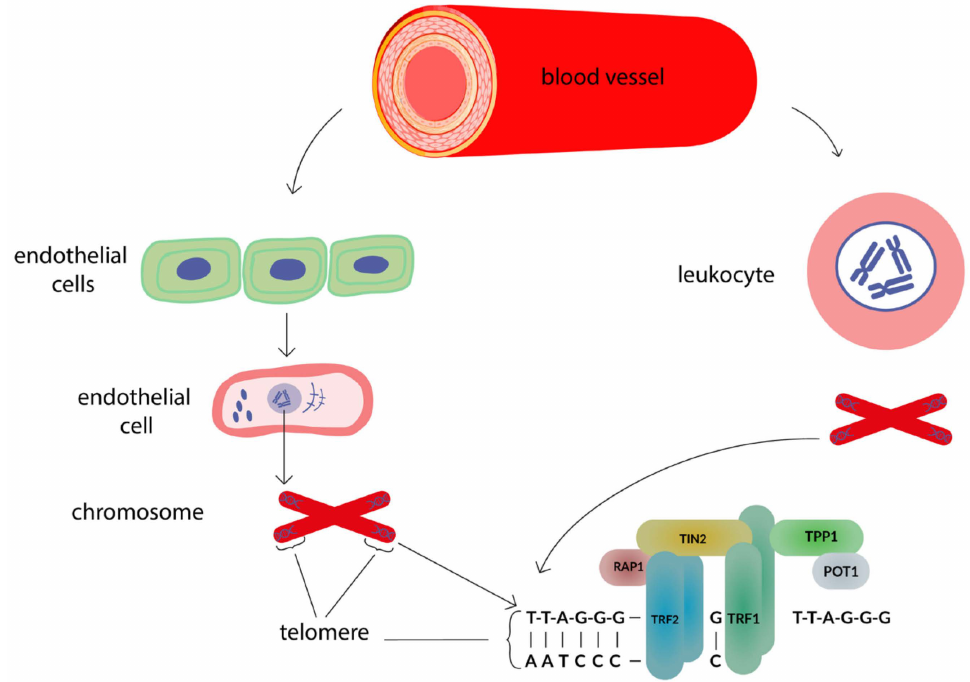
Figure 1. The relationship between the telomere length of endotheliocytes and